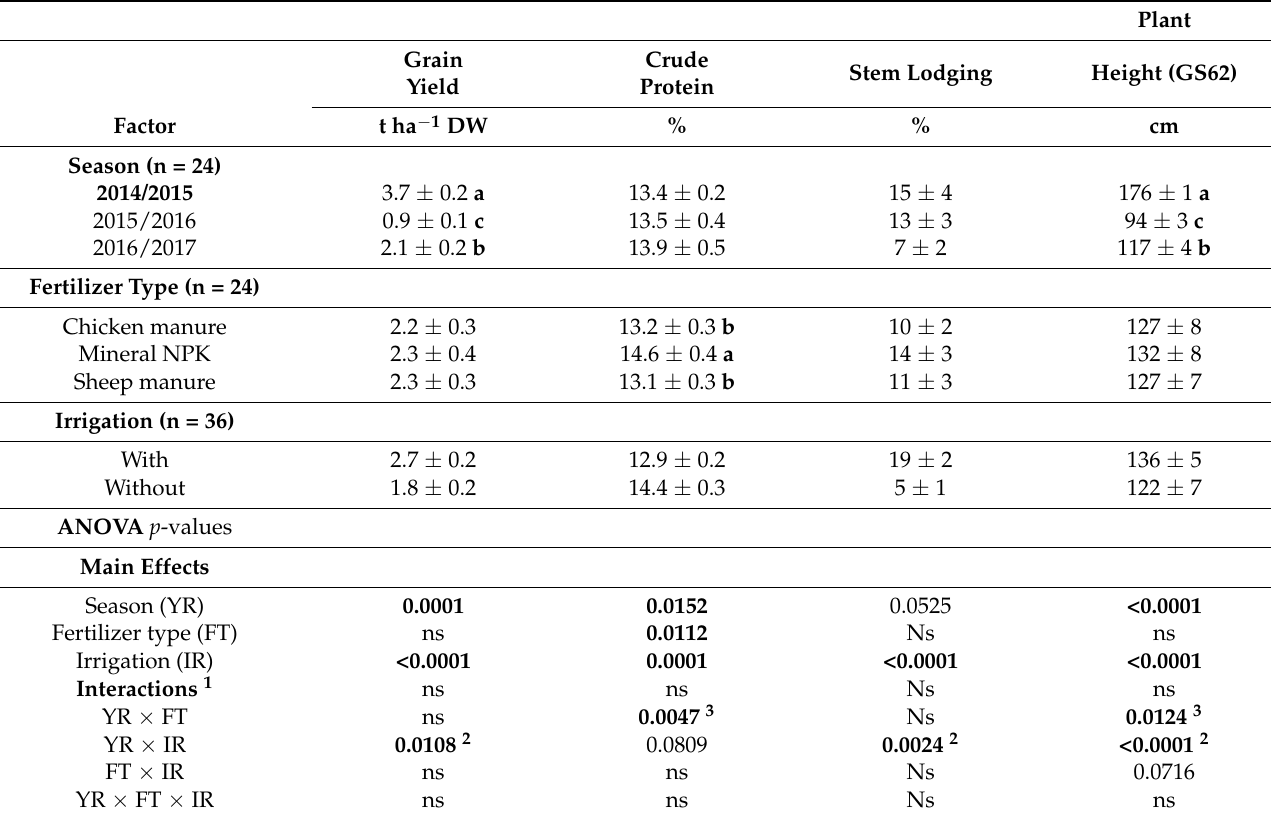
Table 1. Effects of growing season (2014/2015, 2015/2016 and 2016/2017), supplementary irrigation (with or without) and fertilizer type (chicken manure, mineral NPK, sheep manure) on spelt wheat (variety Rubiota) grain yield, crude protein content, stem lodging and plant height. Values shown are the means ± standard